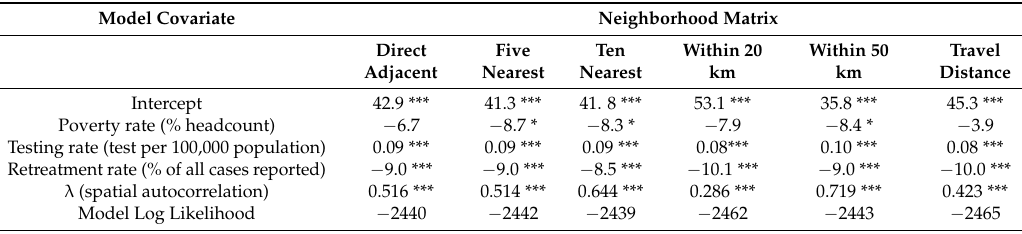
Table 2. Results of fitting a spatial autoregressive model to estimate the number of TB cases reported per 100,000 population per upazila in 2016. Spatial dependencies were accounted for by fitting different models using varying spatial neighborhood matrixes to account for spatially auto correlated